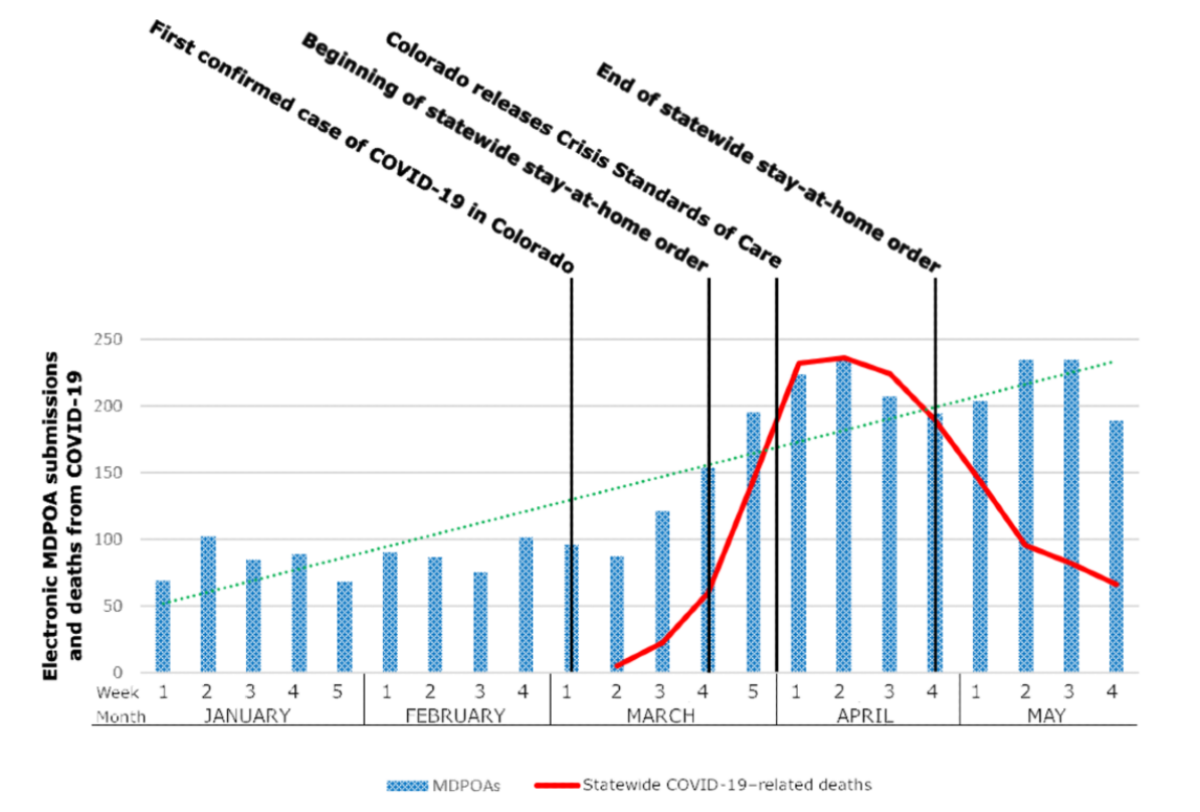
Figure 3. Weekly use of advance care planning portal for electronic MDPOA completion, statewide COVID-19 deaths, and contemporaneous events during the COVID-19 pandemic. COVID-19: coronavirus disease. MDPOA: medical durable power of